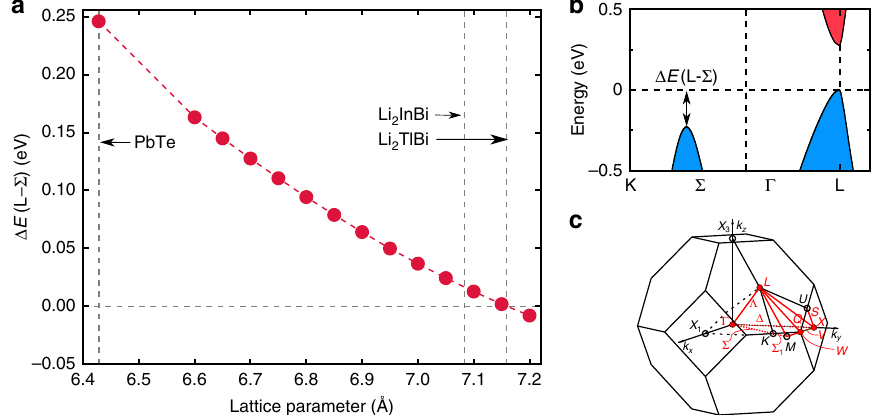
Fig. 3 Lattice induced band convergence. a The valence band energy difference between L and Σ of PbTe as a function of lattice constant. The vertical lines indicates the lattice constants of experimental PbTe and fully relaxed Li 2 TlBi and Li 2 InBi. b Band structure (blue: valence band; red: conduction band) of PbTe along K- Γ -L direction. c High symmetry points/line of the fi rst Brillouin zone of Fm (cid:1) 3